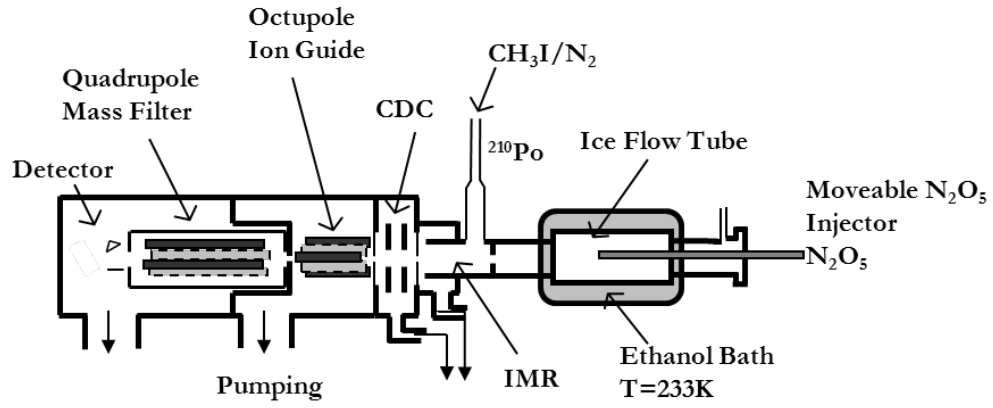
Fig. 1. Schematic of the ice-coated wall reactor and CIMS